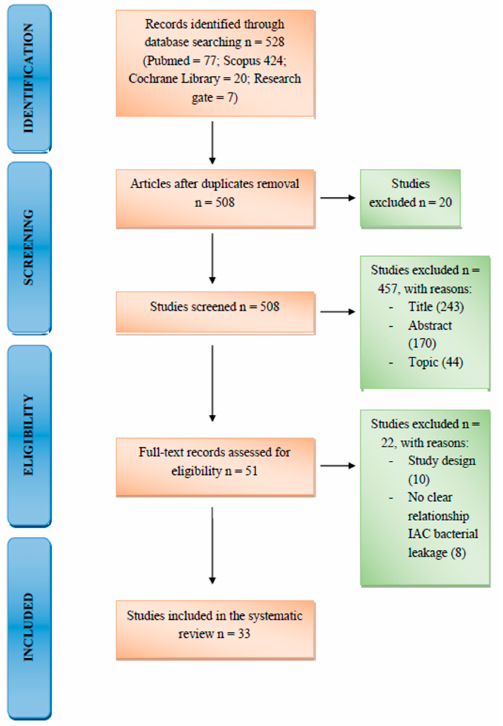
Figure 1. PRISMA Flow Diagram.